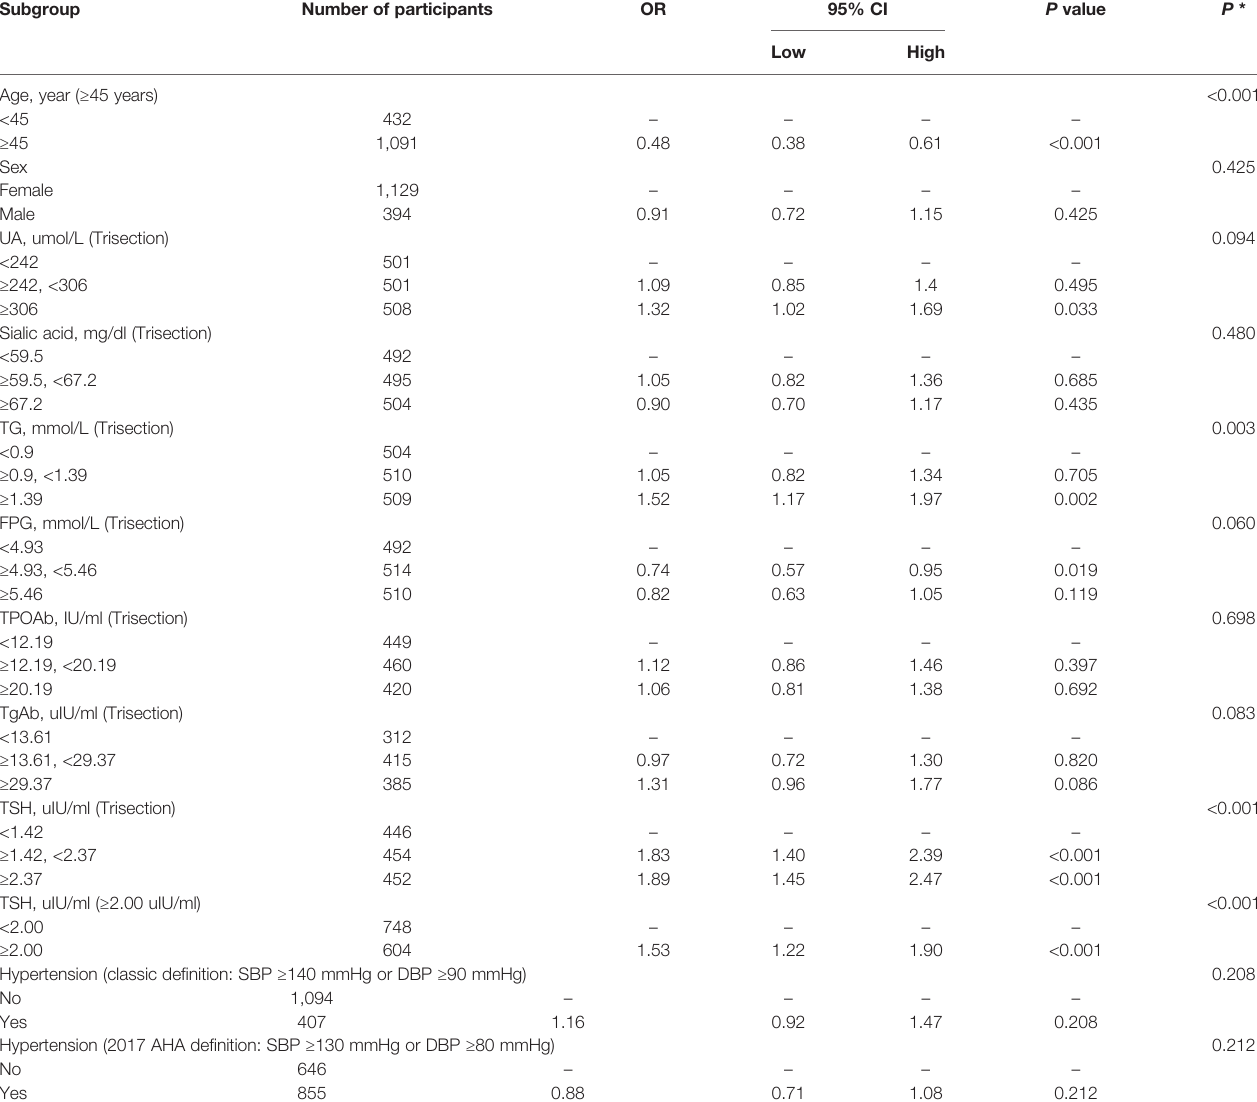
TABLE 2 | Association between hypercholesterolemia and risk of DTC according to baseline characteristics.